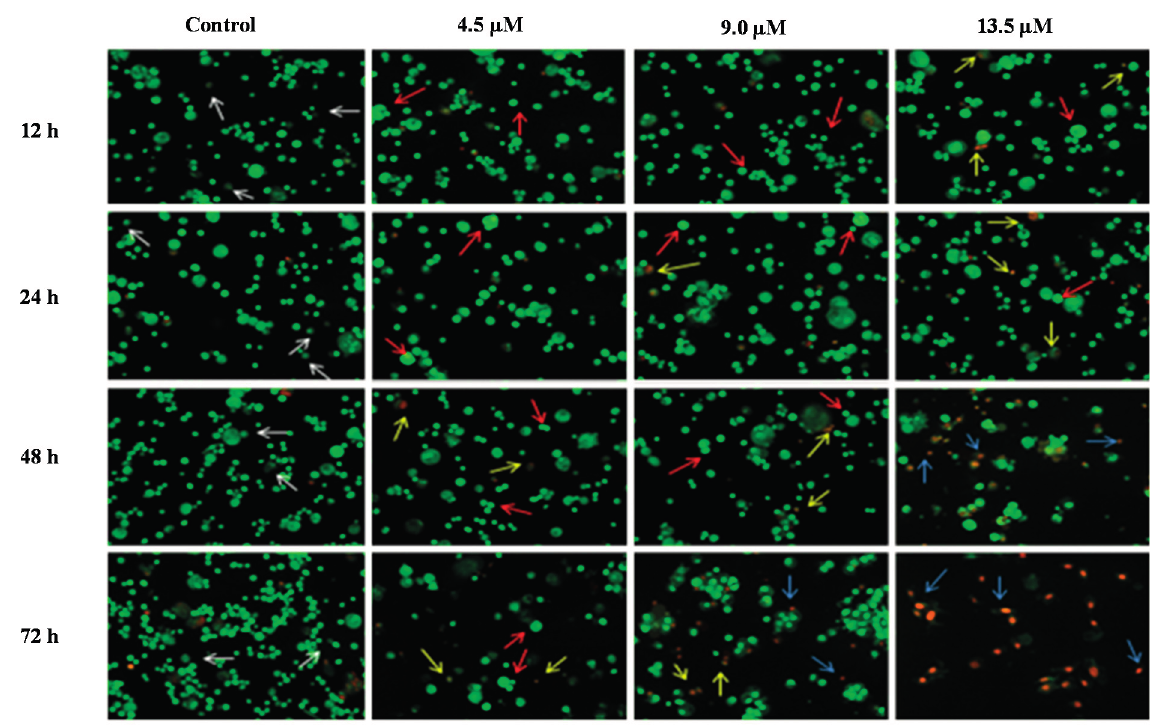
Figure 7. Detection by fluorescent microscope of acridine orange/ethidium bromide double stained DU 145 cells treated with MS17 for 12, 24, 48 and 72 h. Untreated viable cells are uniformly pale-green (white arrow); Early apoptotic cells shows characteristic loss of membrane integrity and chromatin condensation, stained bright-green to yellow (red arrow); Late apoptotic cells stained yellow-orange or red colour, with a condensed or fragmented chromatin (yellow arrow); Necrotic cells showed bright orange-red in appearance (blue arrow). Magnification